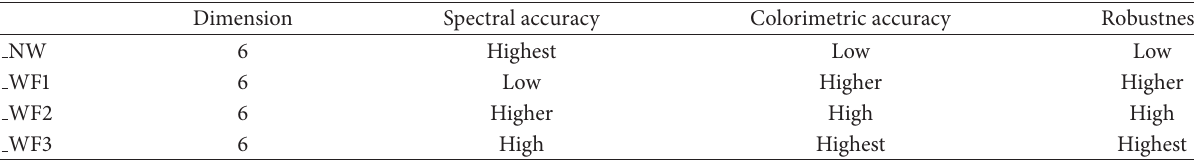
Table 5: Overall performance of the four ICSs.